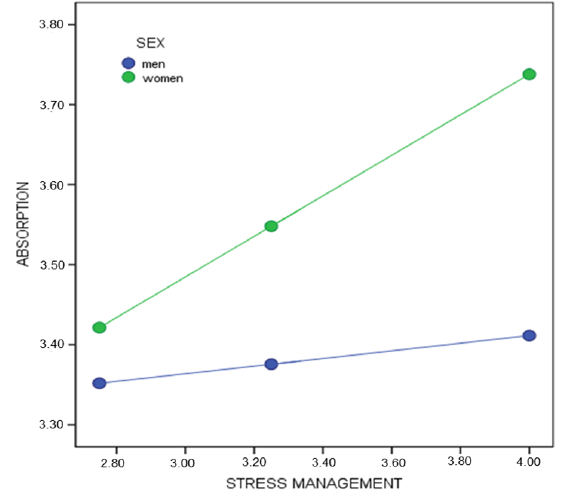
Figure 4. Conditional effect of stress management on absorption by sex